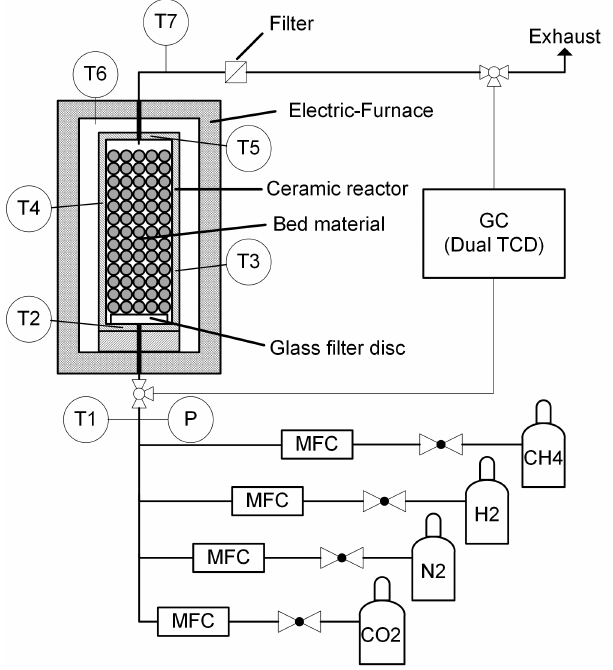
Figure 1. Schematic representation of the experimental